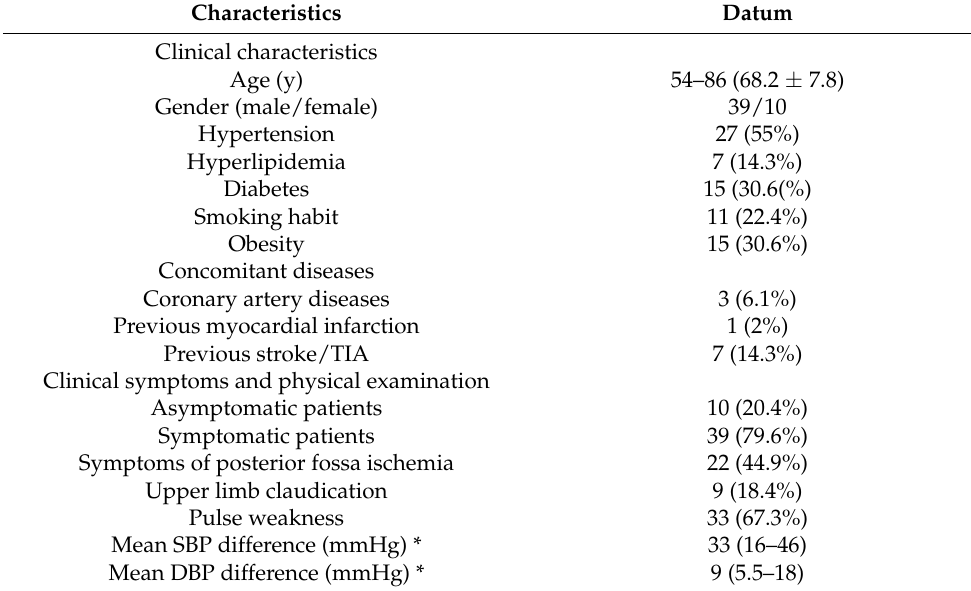
Table 1. Clinical characteristics of 49 patients with CRF in the VA.